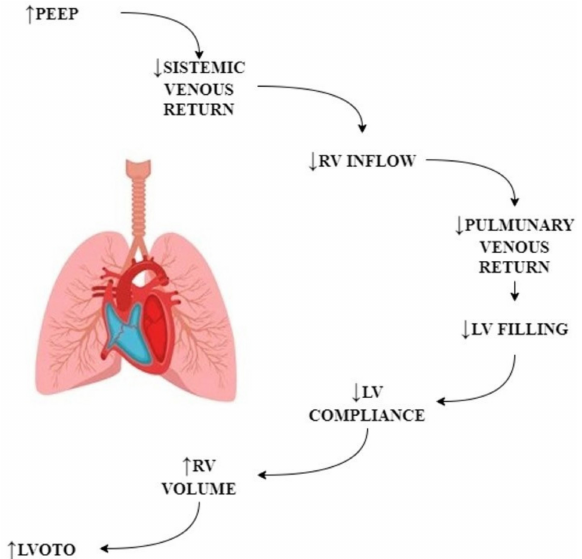
Figure 3. Hemodynamic consequences of mechanical